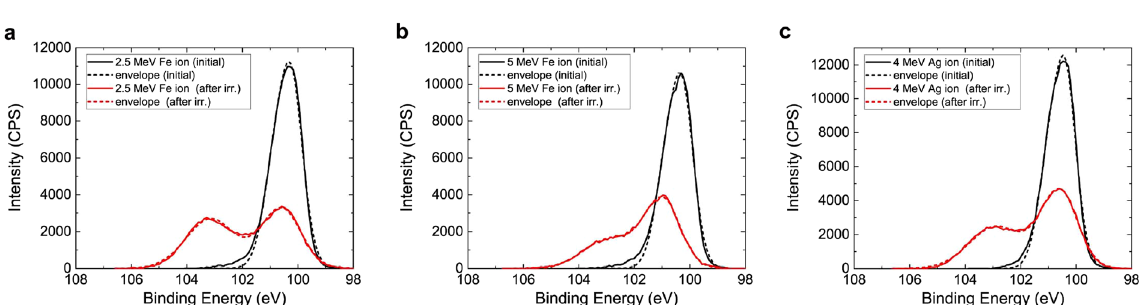
Figure 5. Change of XPS Si 2p 3/2 spectra after heavy ion irradiation. The change of XPS Si 2p 3/2 spectrum after irradiation with ( a ) 5 MeV Fe, ( b ) 2.5 MeV Fe, and ( c ) 4 MeV Ag ions at a fluence of 10 16 ions/cm 2 . The appearance of new peak indicates the oxidation of